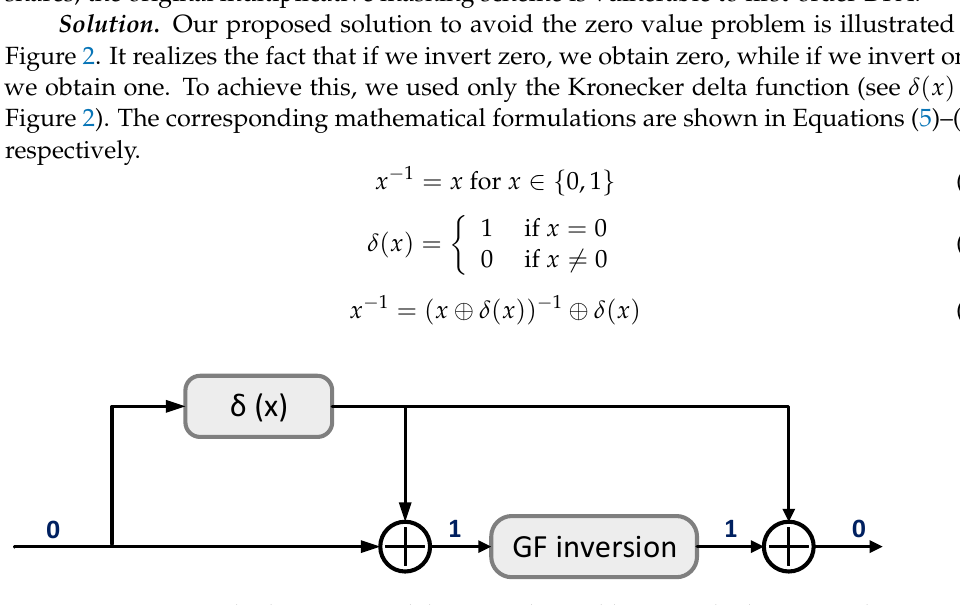
Figure 2. Our proposed solution to avoid the zero value problem in multiplicative